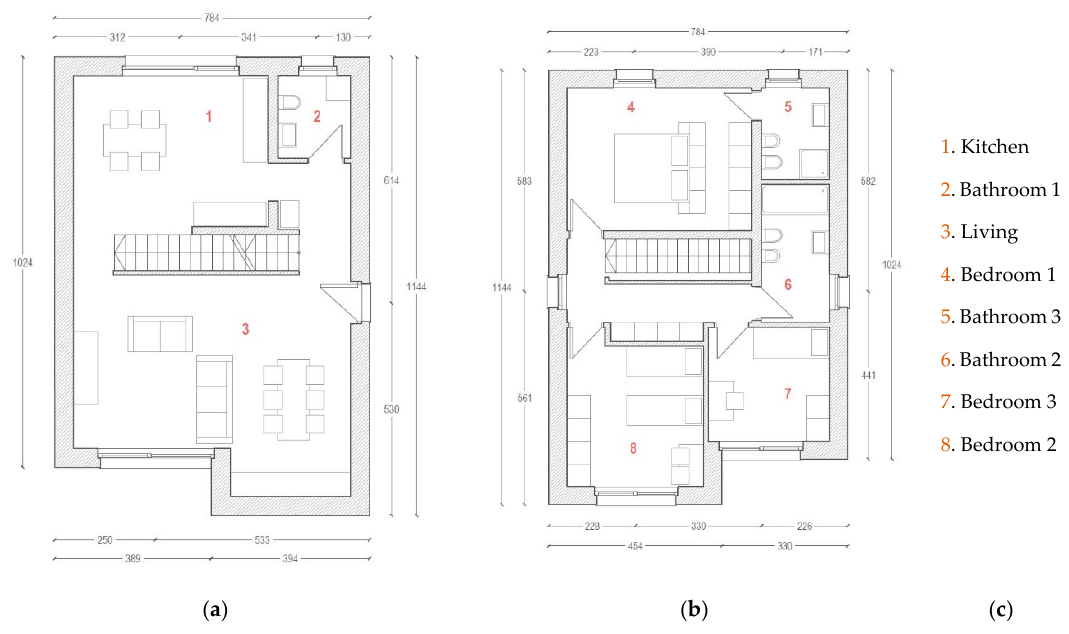
Figure 3. Plan of the apartment: ( a ) ground floor and ( b ) first floor.